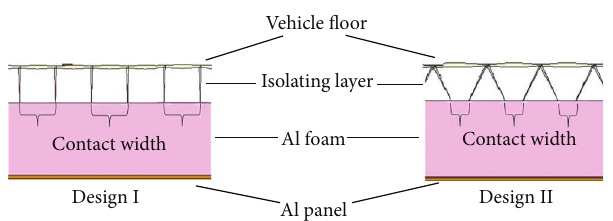
Figure 9: Design variations of sandwich armor structure with isolating